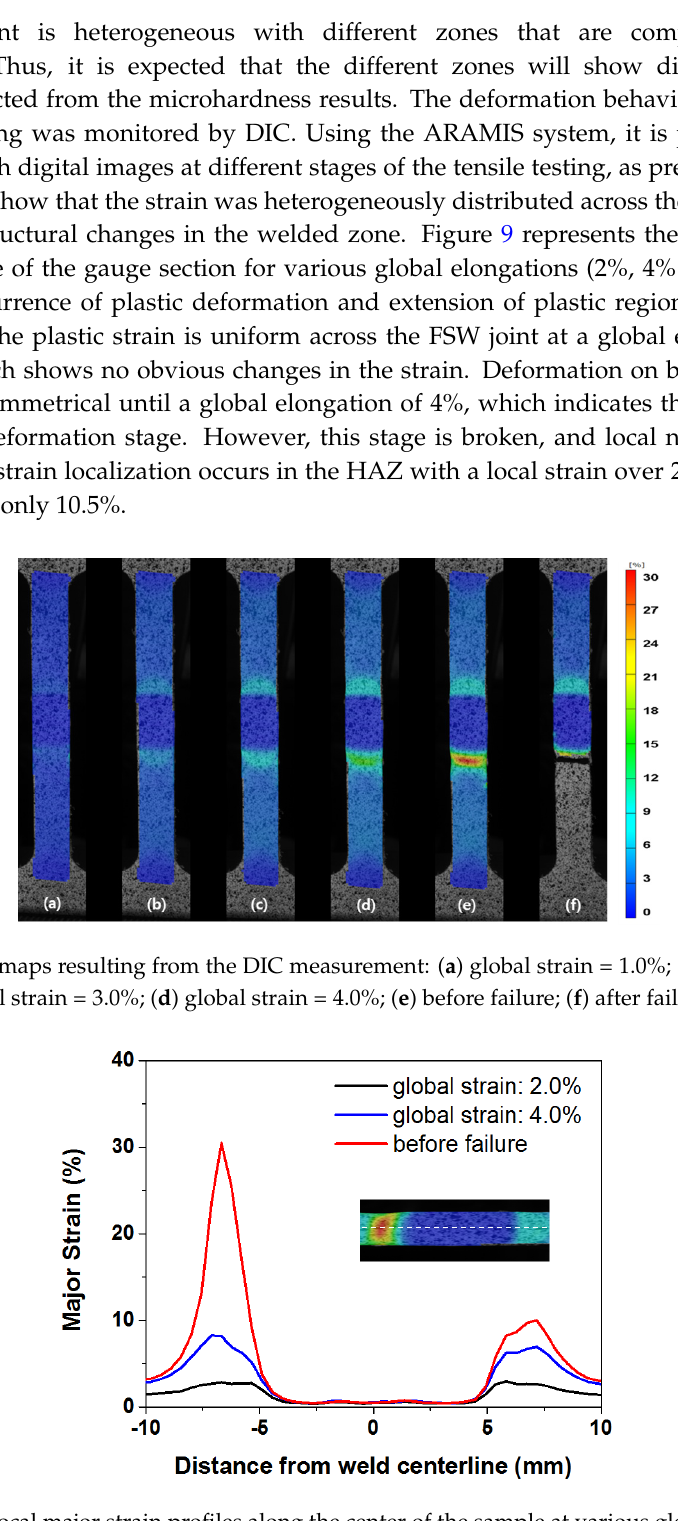
Figure 7. Work hardening rate with respect to net flow stress for DP980 base metal and FSW joint.